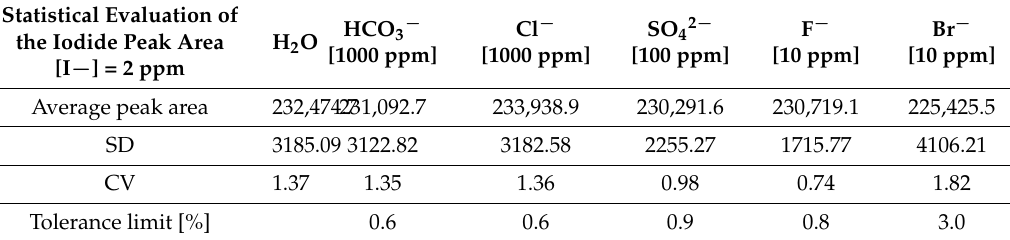
Table 7. The influence of selected anions on the surface area of iodine peaks in the standard